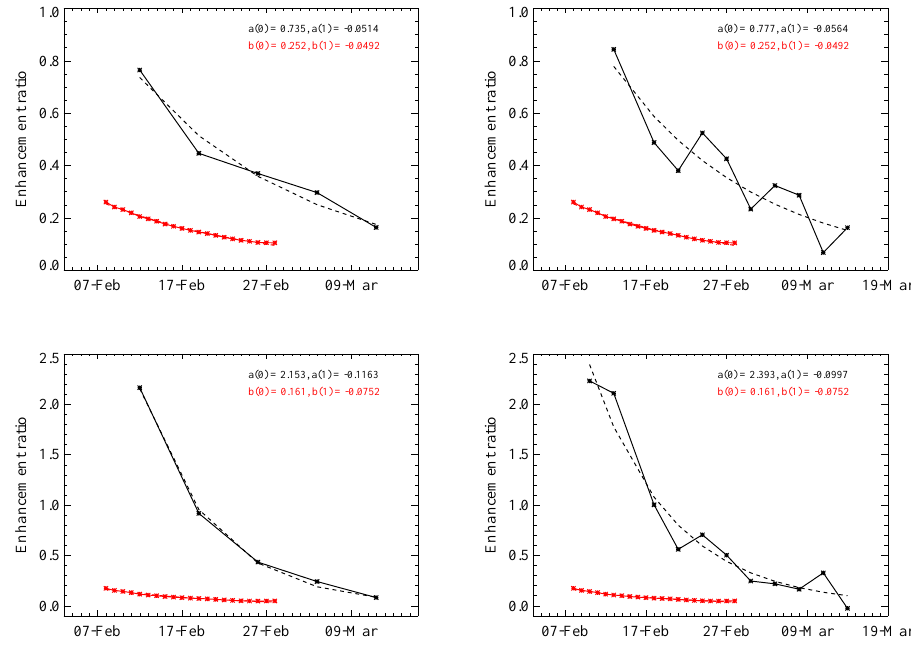
Fig. 16. Top: time series of measured (solid black curves with symbols) and modelled C 2 H 2 /HCN enhancement ratios (solid red curves with symbols). Measured time series are for the altitude region 17–21km and 7-day (left) as well as 3-day bins (right), modelled time series for levels 4–11 ( ∼ 17–21km) and 1-day bins. Dashed curves are two-parameter exponential fits (hardly visible for model data). Bottom: same as top panel, but for HCOOH/HCN enhancement ratios.